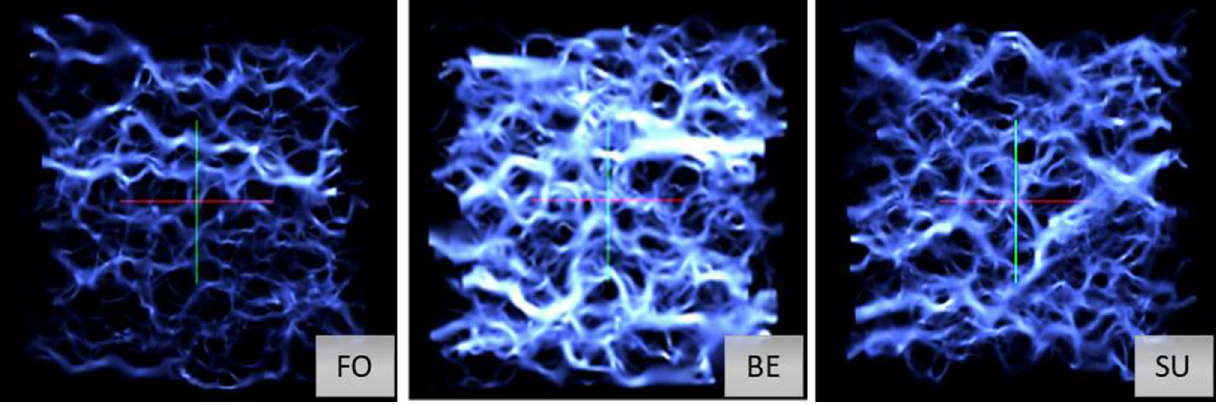
Fig. 5 Flow paths of rock samples (FO, BE, and SU). White colored streamlines represent flowpath. Porosity of both total and effective, percent- age of closed pores, permeability and its degree of anisotropy are presented in Table